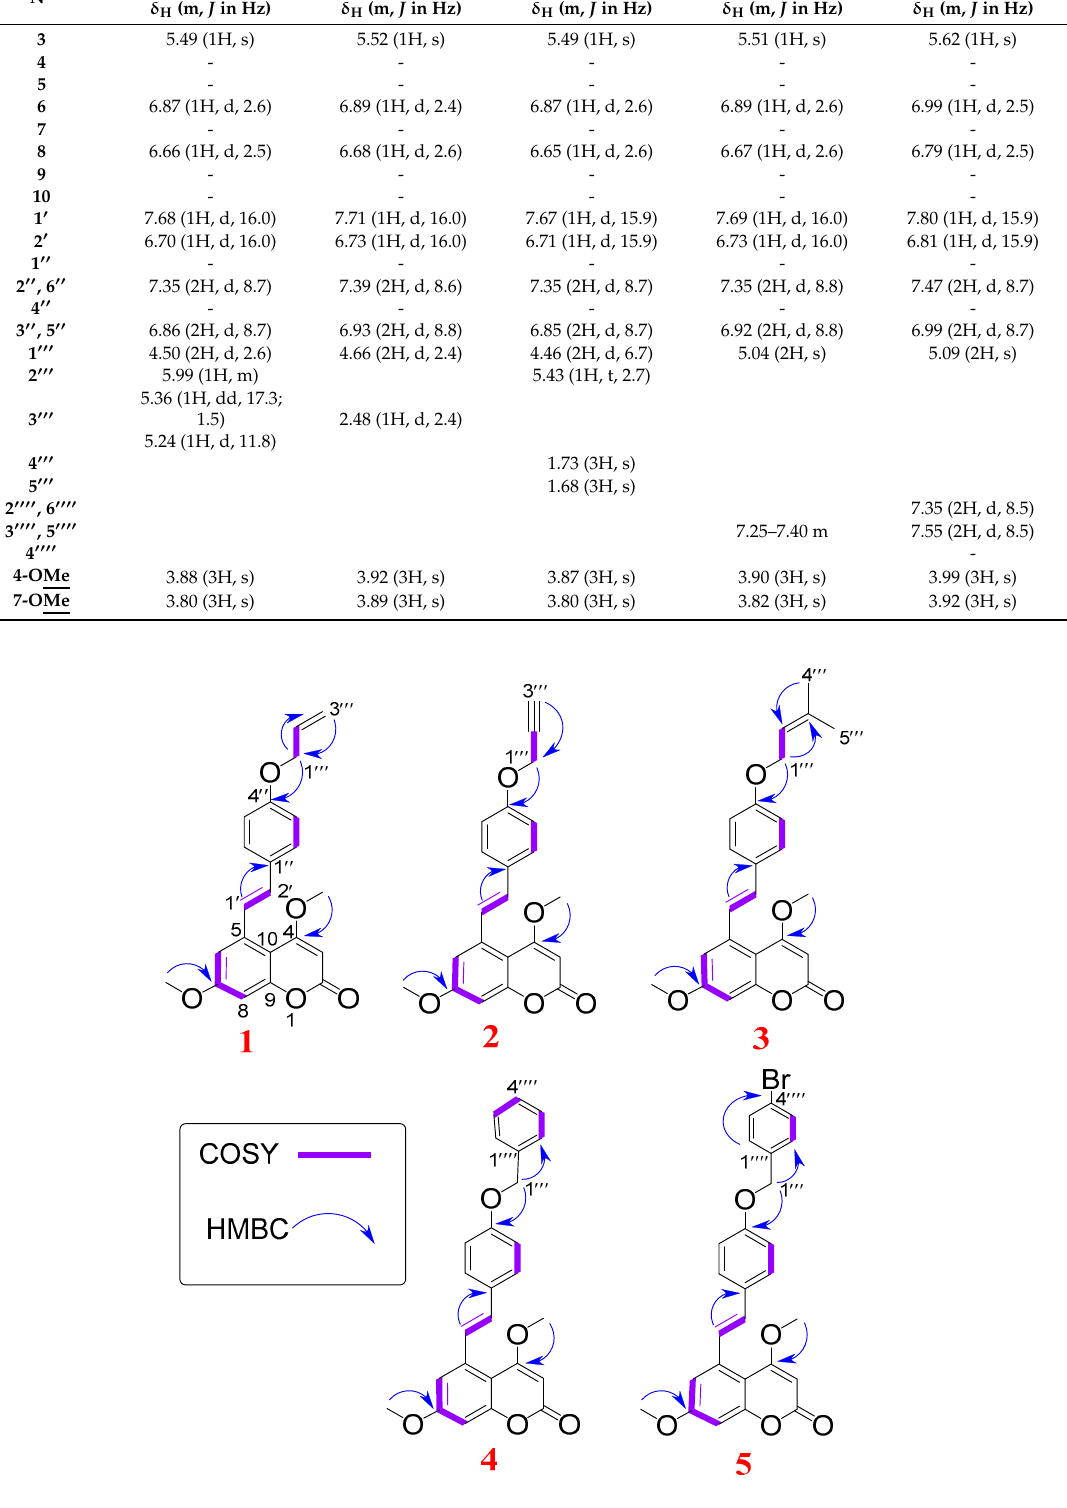
Figure 2. COSY and HMBC correlations of compounds 1a–e .